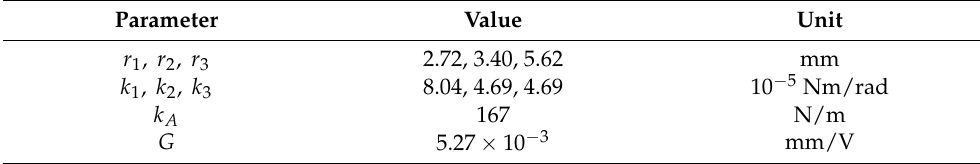
Table 1. Parameters for simplified theoretical